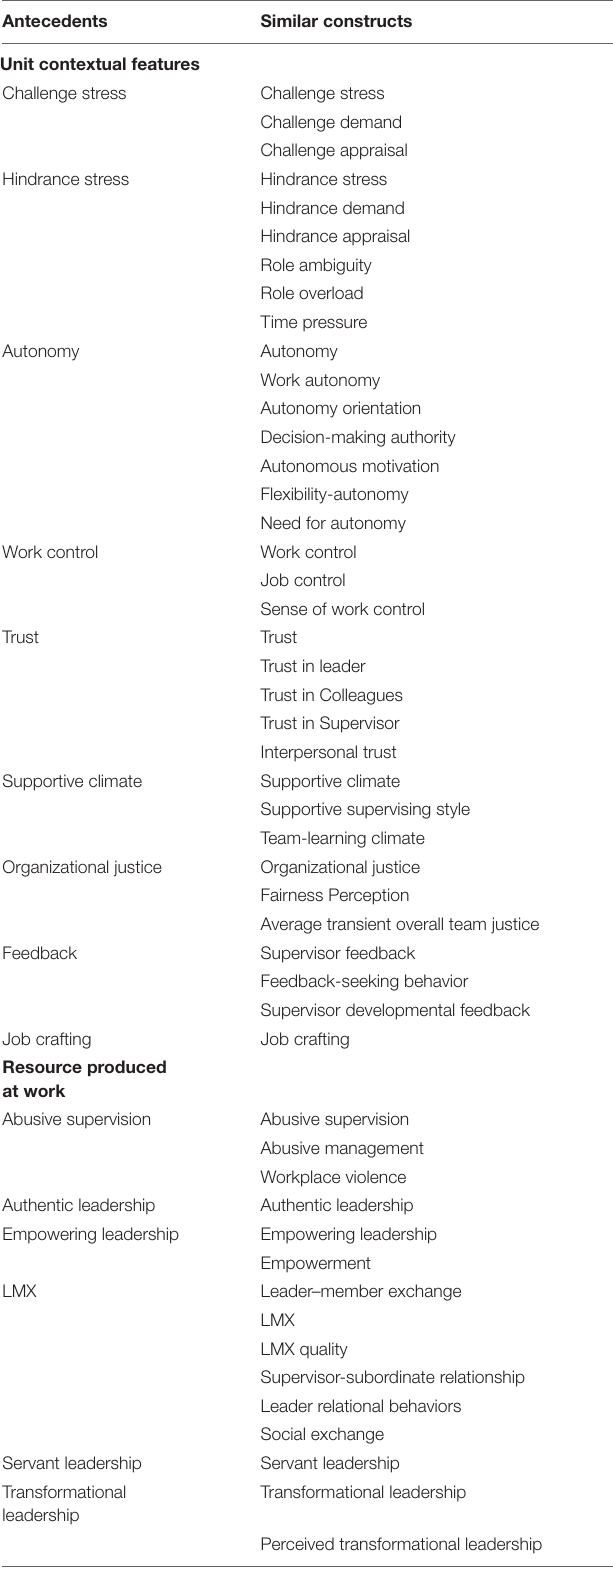
TABLE 2 | Summary of similar constructs used to identify specific